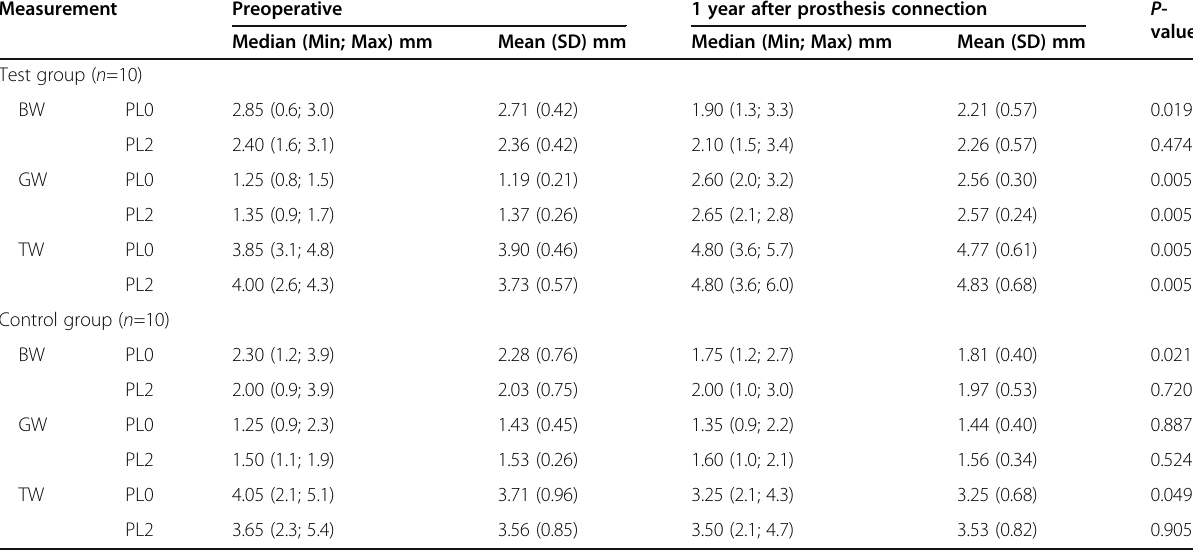
Table 2 Horizontal facial hard and soft tissues and mucosal contour changes following immediate implant placement Measurement Preoperative